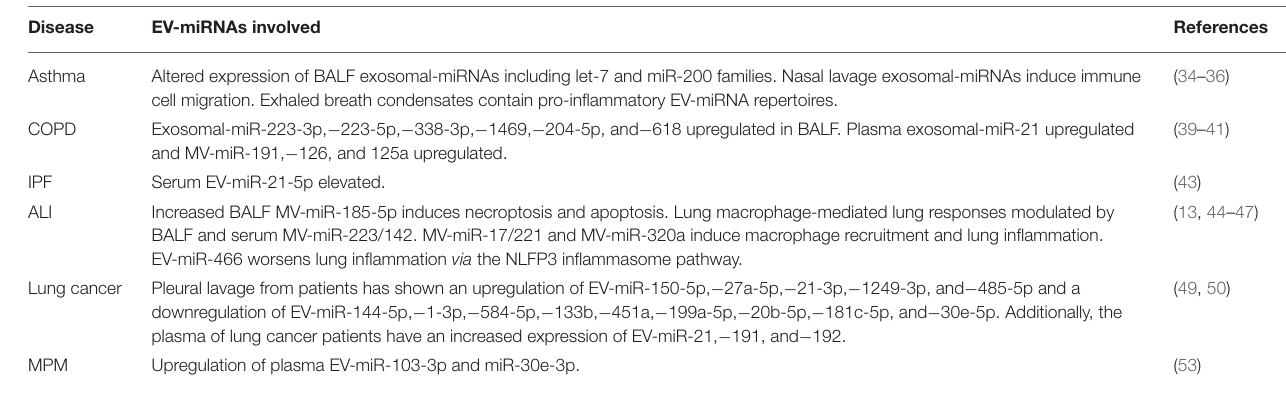
TABLE 1 | Summary of reported EV-miRNAs in respiratory diseases.